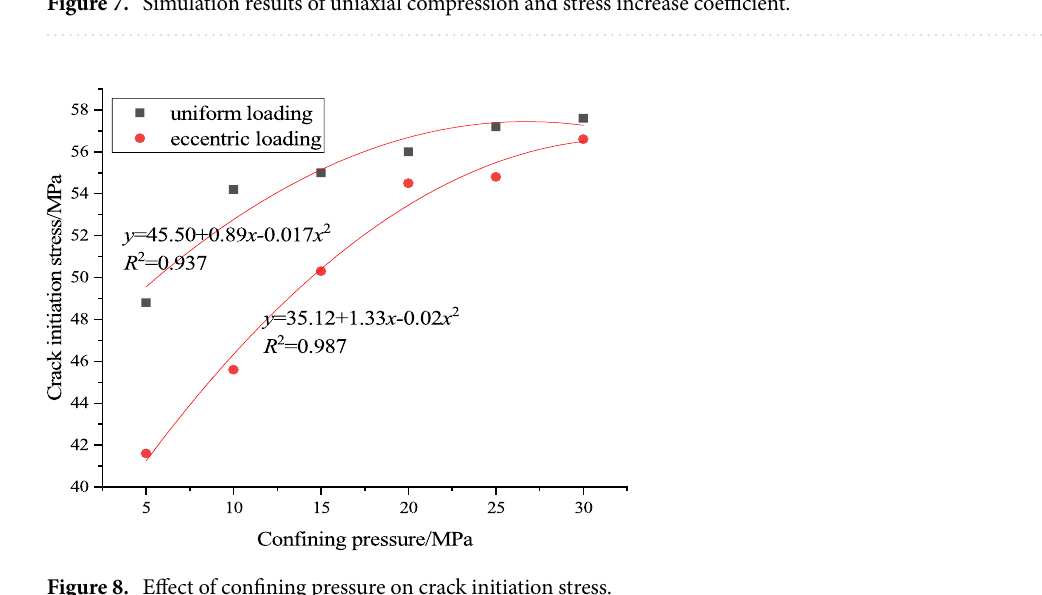
Figure 8. Effect of confining pressure on crack initiation